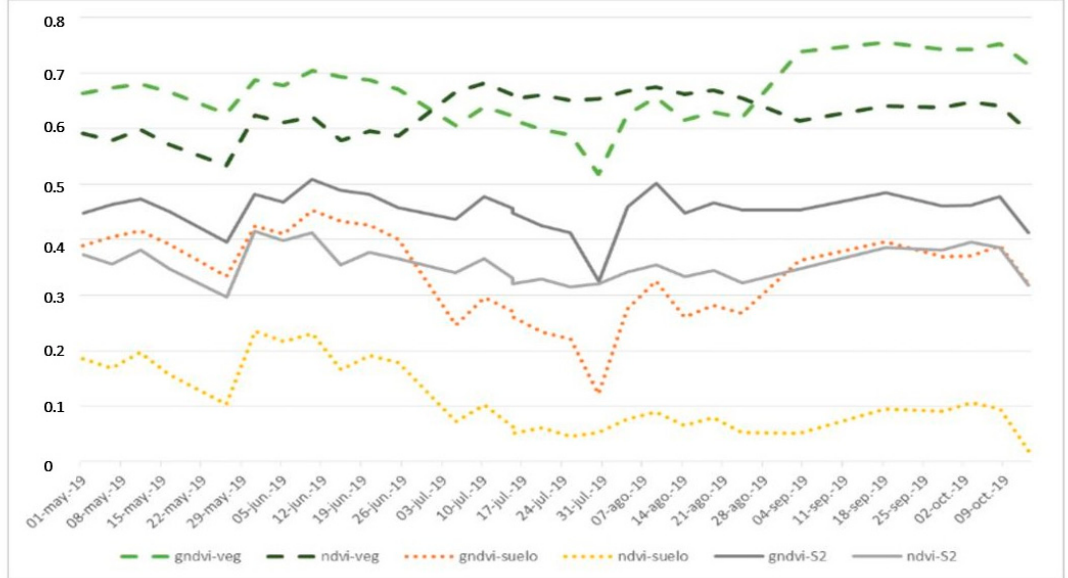
Figure 4. Evolution of the NVDI and GNDVI spectral indices of a point associated with vegetation (green striped lines: ndvi-veg, gndvi-veg), of a point associated with soil (brown dotted lines: ndvi- soil gndvi-ground) and of the pixel in which these points are located in the Sentinel 2 images (gray continuous lines: ndvi-S2, gndvi-S2). Period: 1 May to 31 October 2019 .